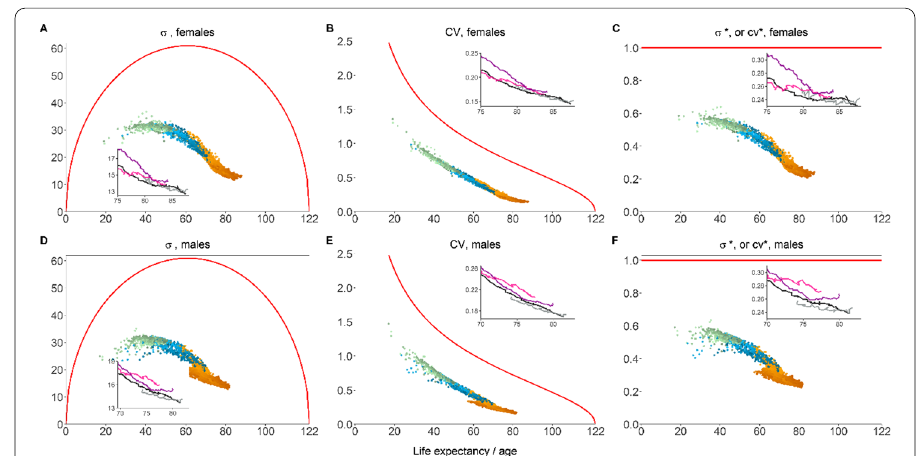
Fig. 10 Life expectancy and lifespan inequality for different inequality indicators, 1832–2020, HMD countries. A Standard deviation for females; B coefficient of variation for females; C normalized standard deviation or coefficient of variation for females; D standard deviation for males; E coefficient of variation for males; F normalized standard deviation or coefficient of variation for males. Red curve for maximal inequality given maximal lifespan 122, black line for Japan, dark magenta line for Canada, pink line for Taiwan, grey line = for Hong Kong. Normalized indices were calculated when maximal lifespan equals 122 (Source: Authors’ elaboration based on the HMD data)